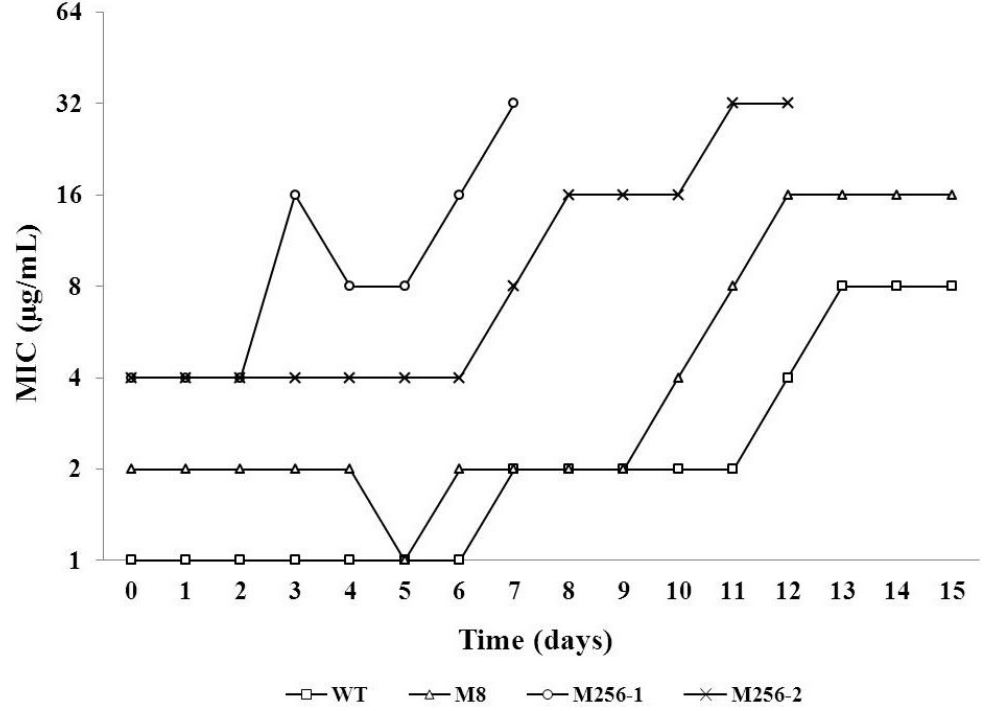
Figure 5. The MICs as a function of time during the adaptation of E. coli strains to stepwise increasing concentrations of cefotaxime, starting at 0.06 µg/mL for WT (MIC = 1 µg/mL) and WT 5a (see Figure 1; MIC = 2 µg/mL) and at 0.5 µg/mL for the two duplicate strains of M256, indicated as M256-1 and M256-2.